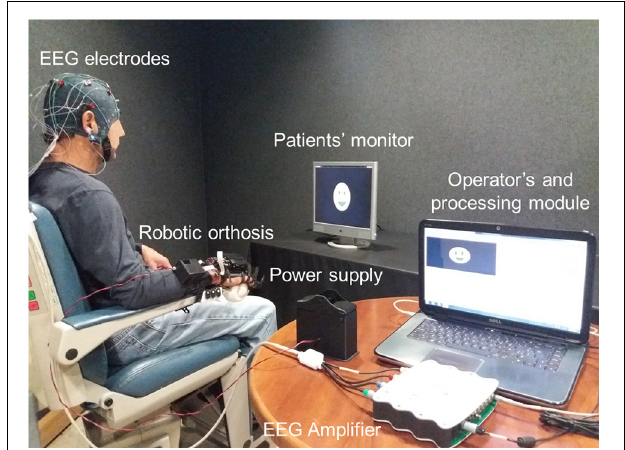
FIGURE 1 | ReHand-BCI system. Acquisition stage comprised of EEG electrodes, amplifier, and A/D converter. The processing module included CSP, PSO, and LDA programmed in a PC, which also has a graphical user interface for setting up therapy parameters. Commands are sent through wireless communication from the PC to the robotic hand orthosis.